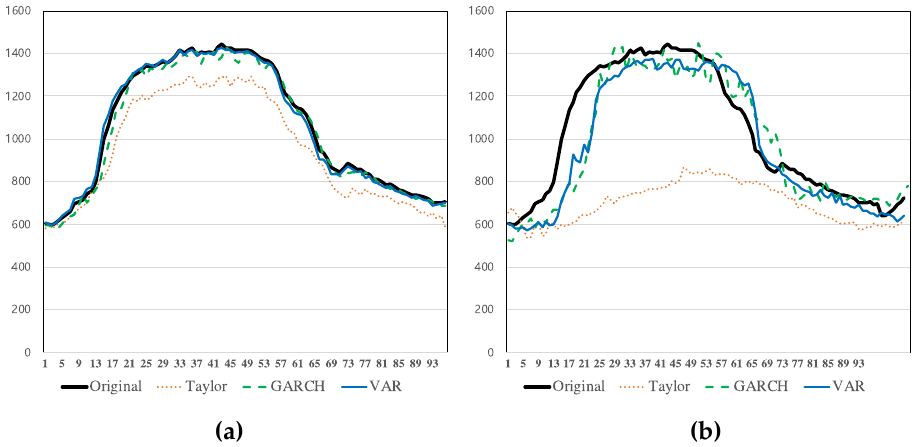
Figure 7. Comparison between the original values and each model from ( a ) forecast (k = 1) and ( b ) forecast (k = 8).